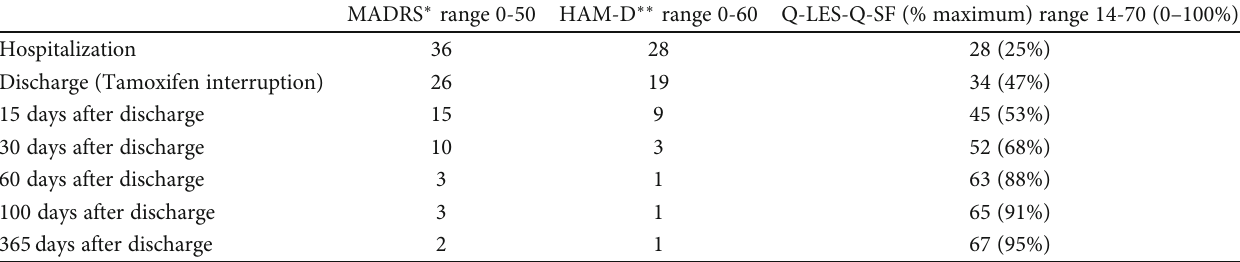
Table 1: Patient MADRS, HAM-D, and Q-LES-Q-SF scores at second hospitalization, discharge, and one-year